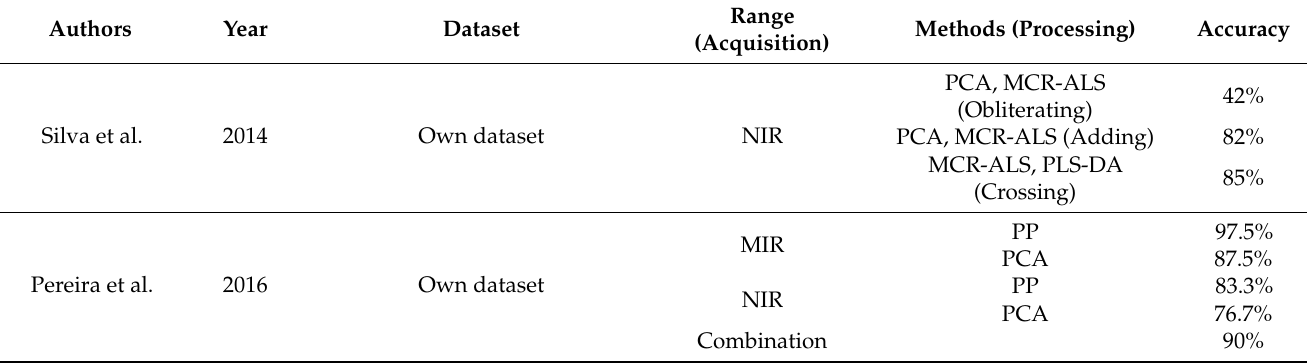
Table 2. Comparison of studies